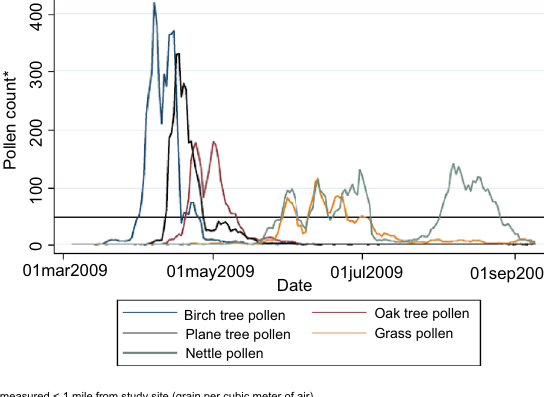
Figure 1. Distribution of submicron particle count/L in exhaled air.